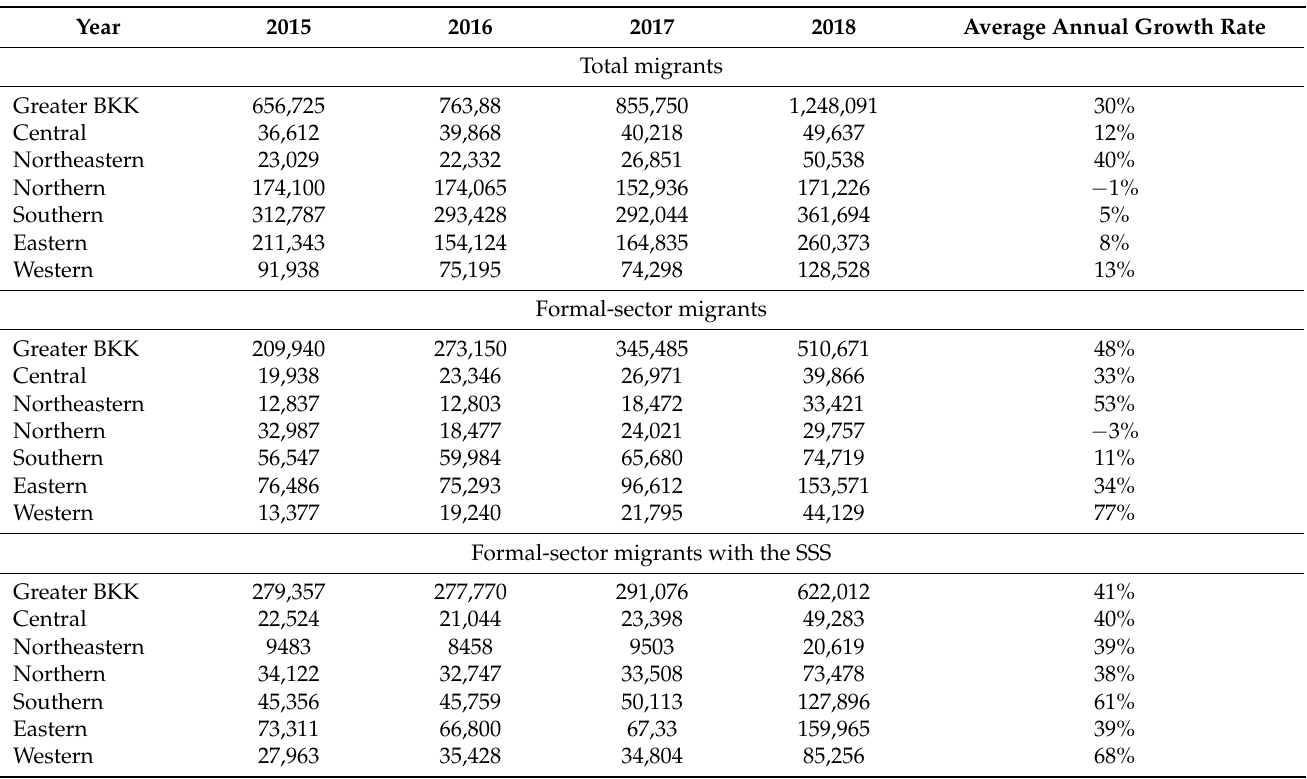
Table 1. Number of migrants by regions, 2015–2018.